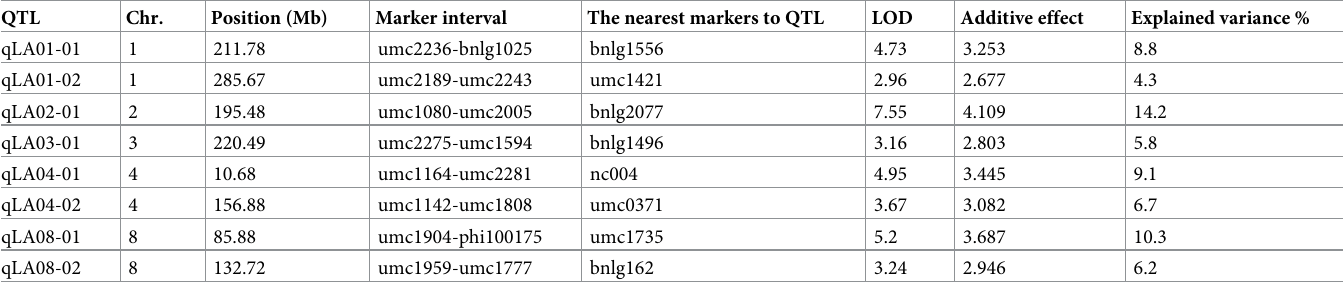
Additive effect: A positive value indicates that the B73 allele increases the value of the trait; A negative value indicates that the Zheng58 allele increases the value of the trait.